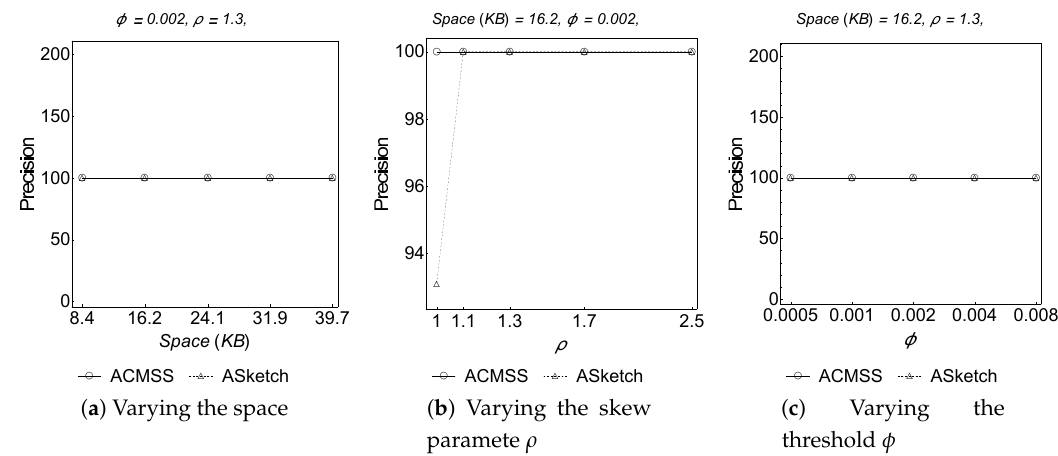
Figure 5. Accuracy of the algorithms: